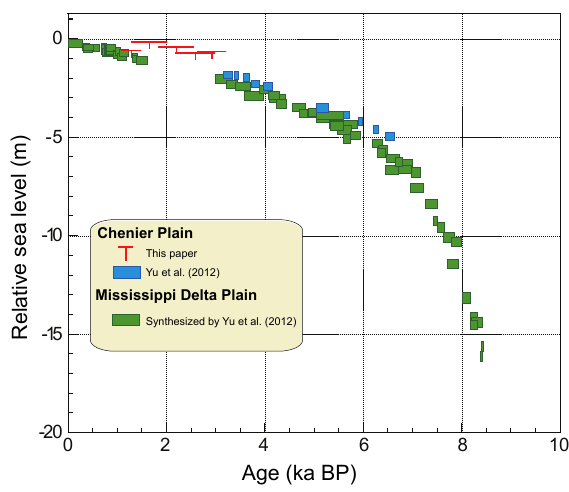
Figure 16. Comparison of Holocene relative sea-level records de- rived from cheniers (this study) and basal peat from the Chenier Plain and the Mississippi Delta plain (Yu et al., 2012). The chenier- overwash data are interpreted as upper limiting data (see text). For the limiting data, the width of the horizontal bar is defined by the 2 σ age error and the length of the vertical bar by its 2 σ error range (Table